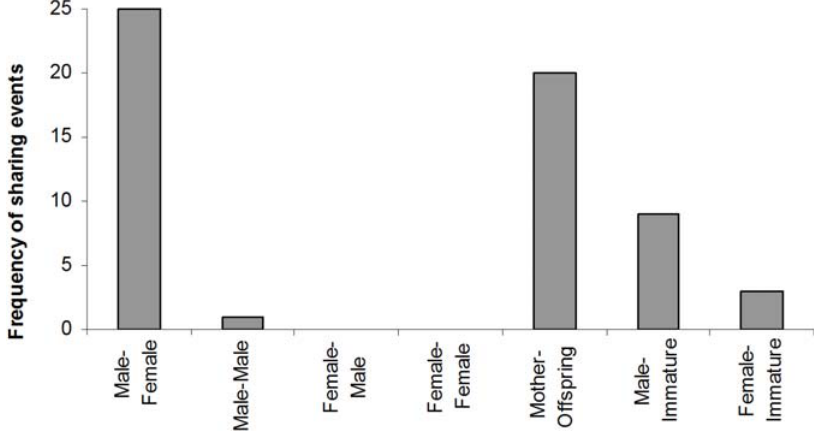
Figure 2. Age/sex classes of crop-sharing dyads. Offspring are of any age, ‘male’ or ‘female’ always refers to adults, and ‘immature’ refers to infants or juveniles less than 8-years old. Mother-offspring (includes offspring-mother) and male-immature sharing may be explained on the basis of kin selection.